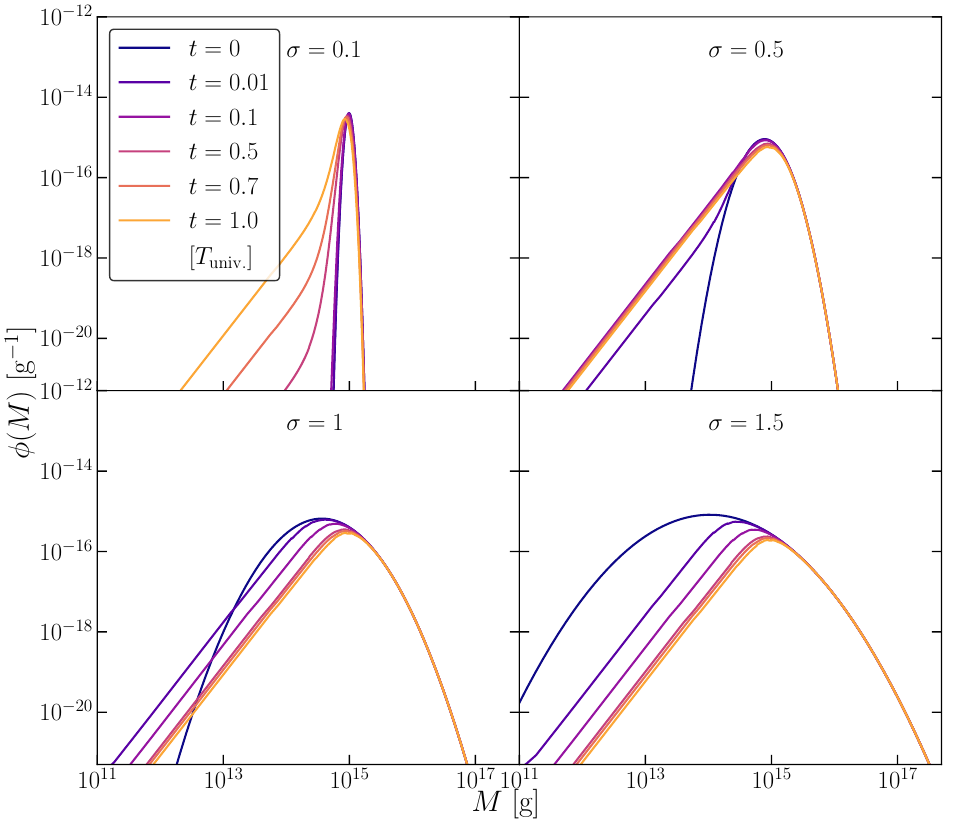
Figure 2: Four PBH extended distributions with M ∗ = 10 15 g and different standard deviations σ are evolved, with line colour denoting evolution time. Note that t is in units of the age of the